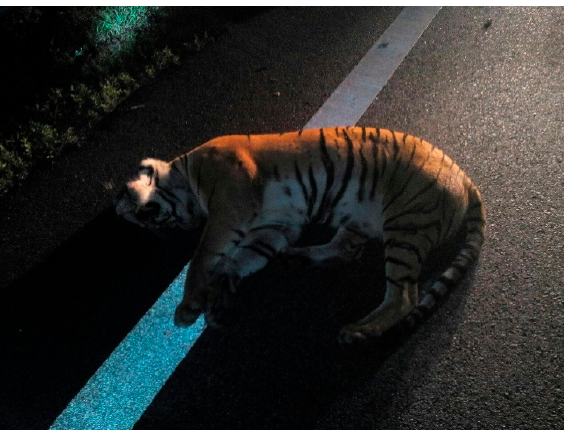
Figure 5. The female Malayan tiger was hit and killed by a high-speed vehicle along East Coast Highway 2 on 7 Feb 2016. Possibly due to the poor maintenance of highway fencing. (Photograph @Ahmad Ikhwan Zainuddin).